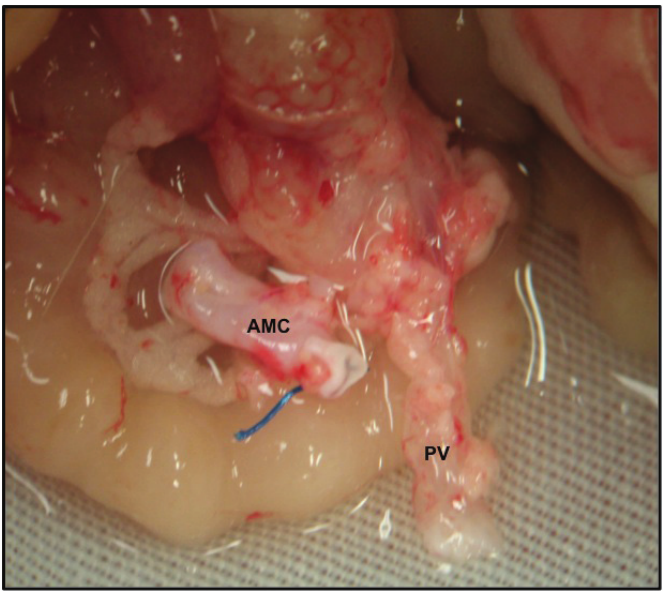
FIGURE 2 - Small bowel graft in preservation solution. AMC , Aortomesenteric conduit; PV , Portal